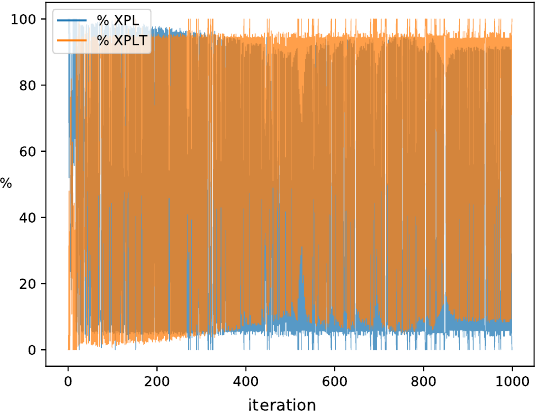
Figure 11. SCA—Exploration and Exploitation Graphic of instance c5 version QL5.